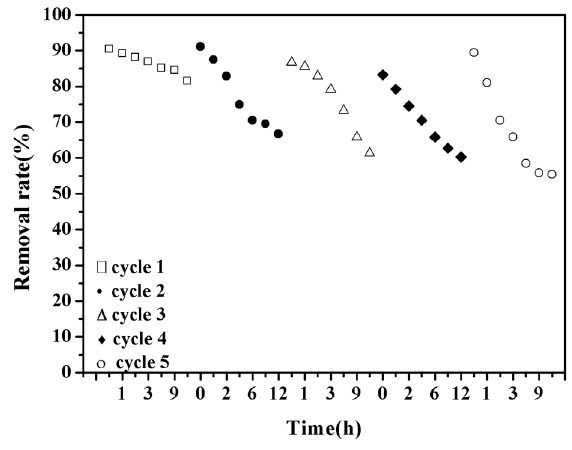
Figure 8. Stability of CSH to adsorb lead ions .